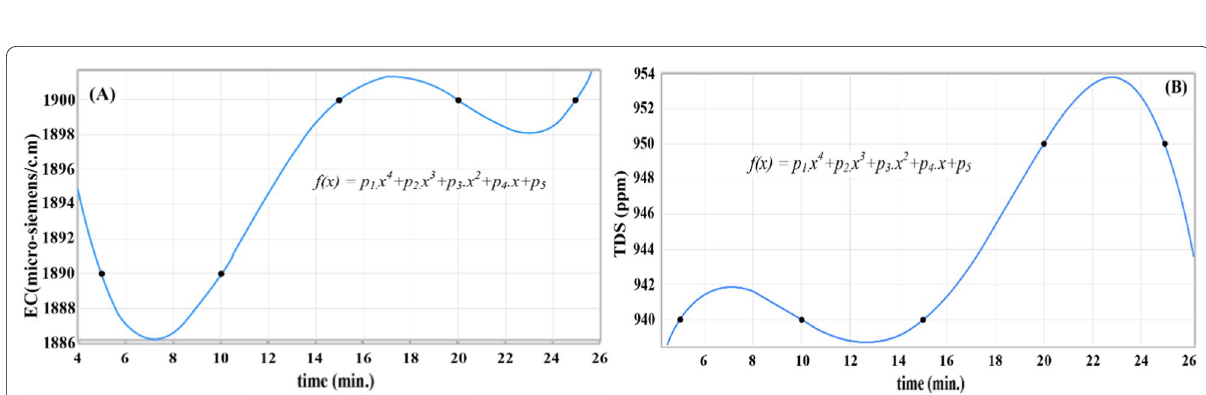
Fig. 9 Brackish groundwater in case of closed cycle at flow rate of 12.32 l/min: A electrical conductivity versus time and B total dissolved solids versus